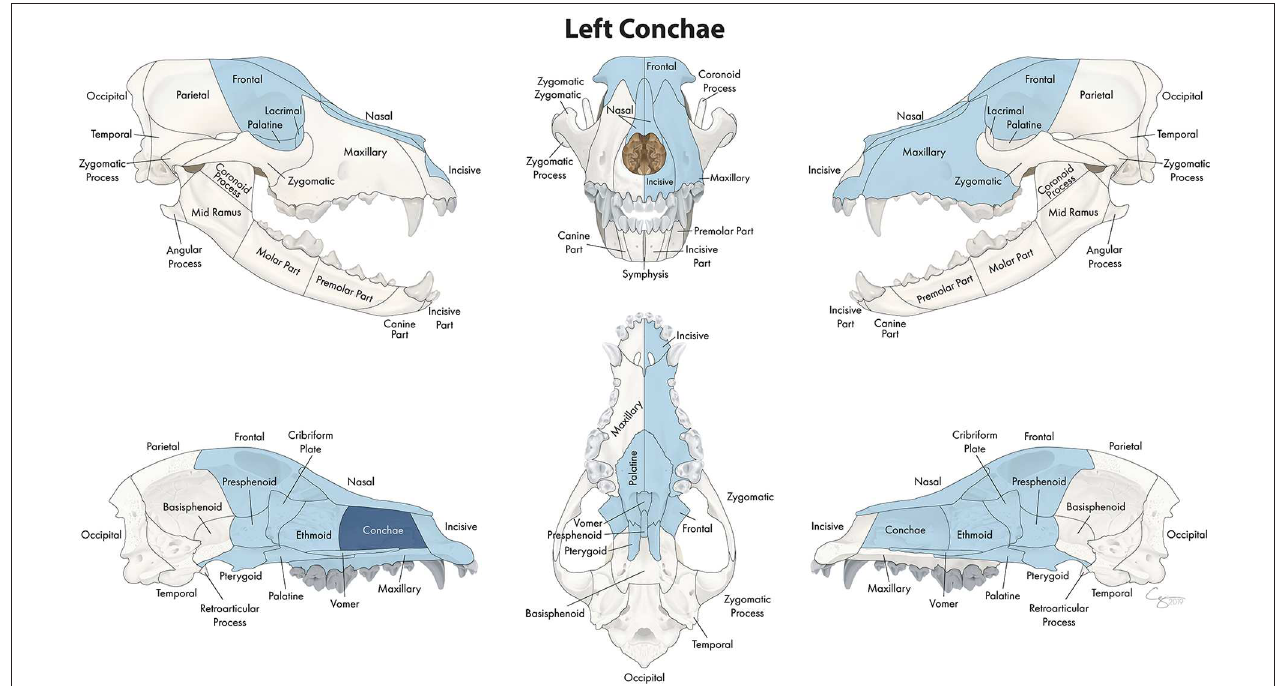
FIGURE 4 | Significant bones or regions fractured concurrently with the conchae. When the conchae were the region of interest, many other bones of the skull base/cranial vault and midface, both on the ipsilateral and contralateral side, fractured concurrently. Although the left conchae are shown, when the right conchae were the region of interest, a mirror image of concurrently fractured locations applied.